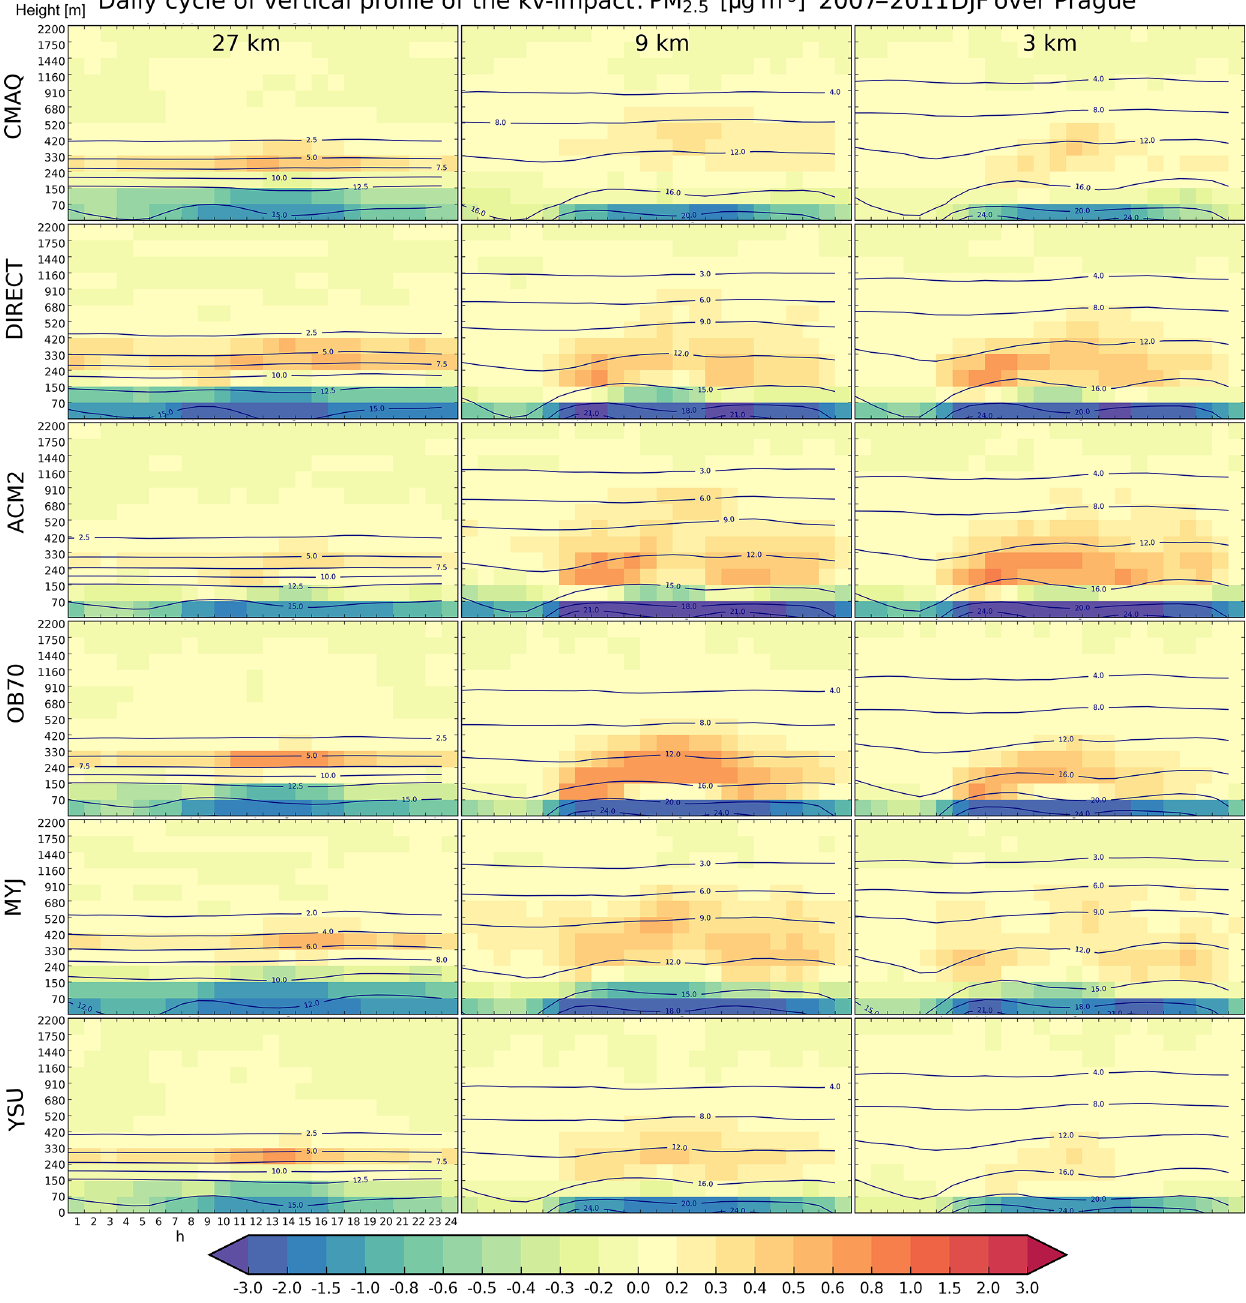
Figure 27. Same as Fig. 26 but for